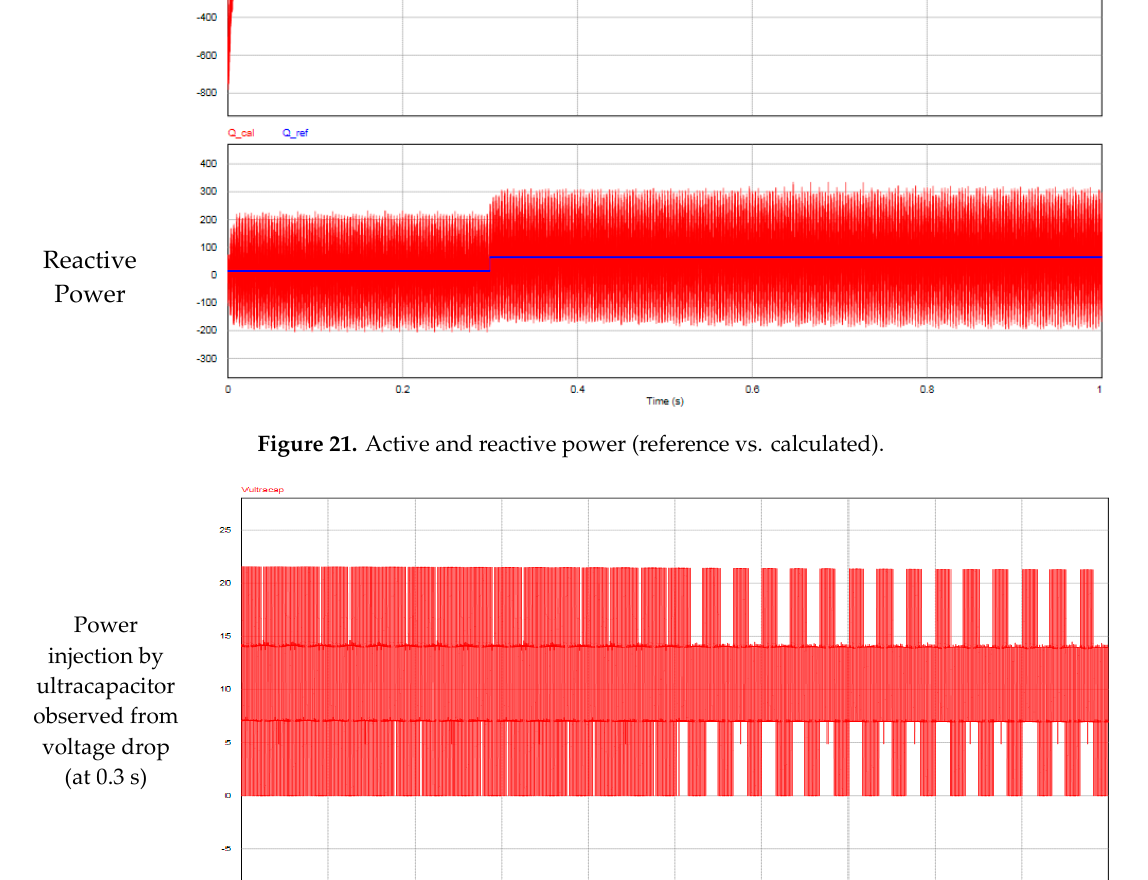
Figure 22. Ultracapacitor voltage.